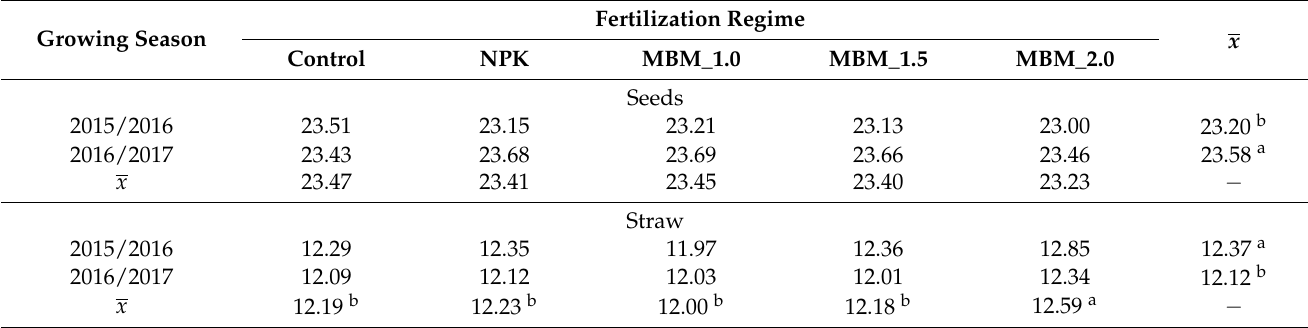
Table 8. Lower heating value of winter oilseed rape biomass (MJ kg − 1